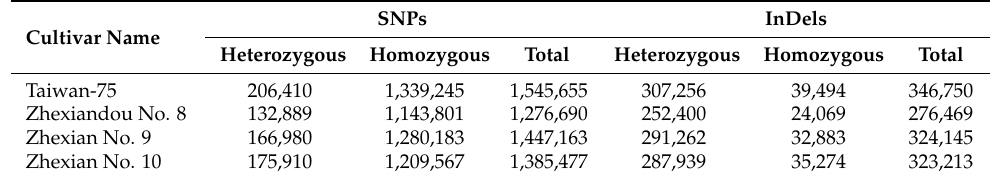
Table 2. The numbers of SNPs and InDels for each cultivar.